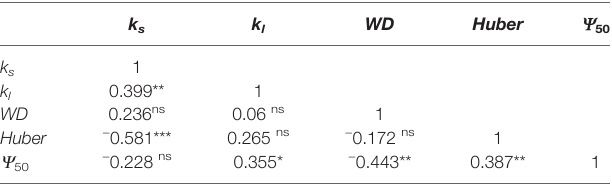
TABLE 4 | Pearson correlations between branchlet hydraulic traits of Populus euphratica .